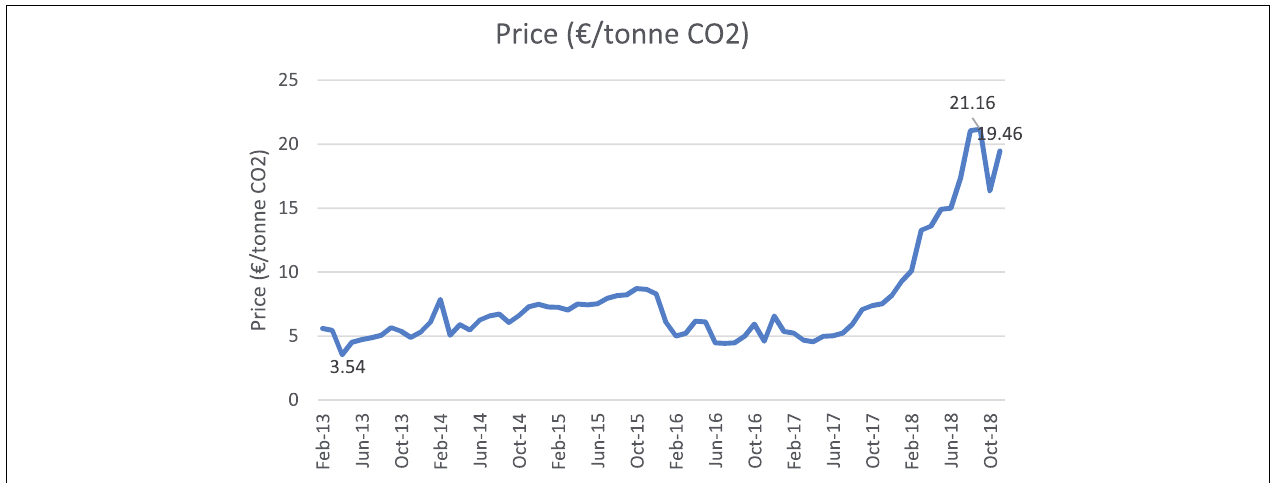
FIGURE 2 | CO 2 emission prices in the European emissions trading system (EU ETS), Phase 3 January 2013 – November 2018. Source: http://www.investing.com/commodities/carbon-emissions-historical-data.